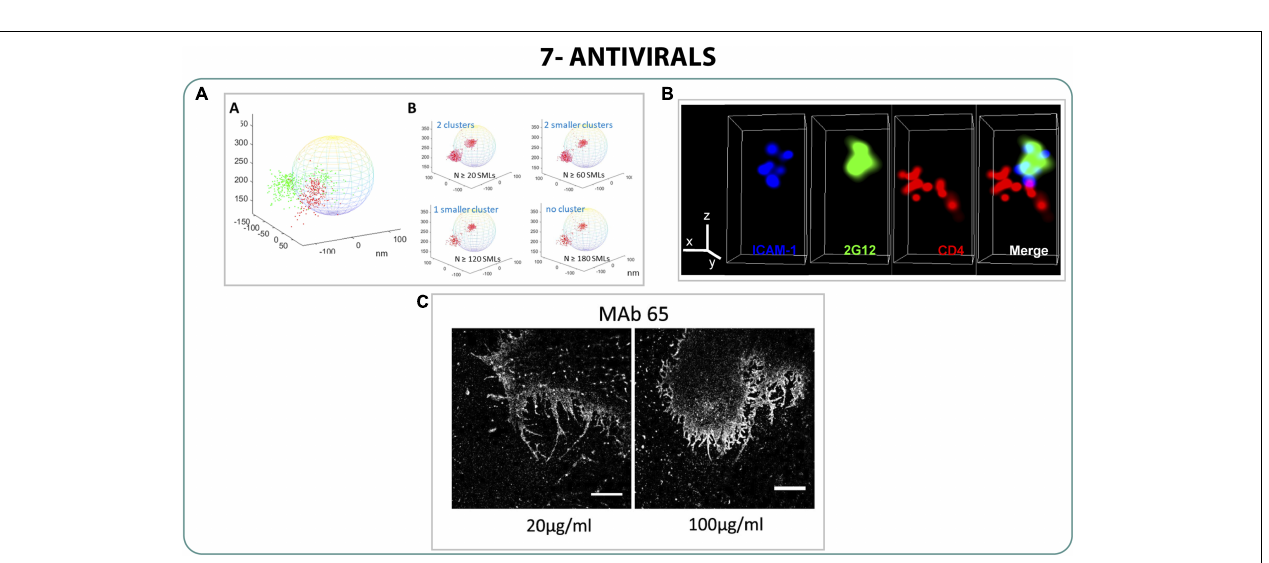
FIGURE 7 | Vaccine structures. (A) Correlative 2-color iPALM and SEM of two virus-like particles during budding from the cell. Scale bar 250 nm (Engelenburg et al., 2014). (B) PALM localization and quantification of the morphology of Gag on HIV-1 VLPs (Gunzenhäuser et al., 2014).